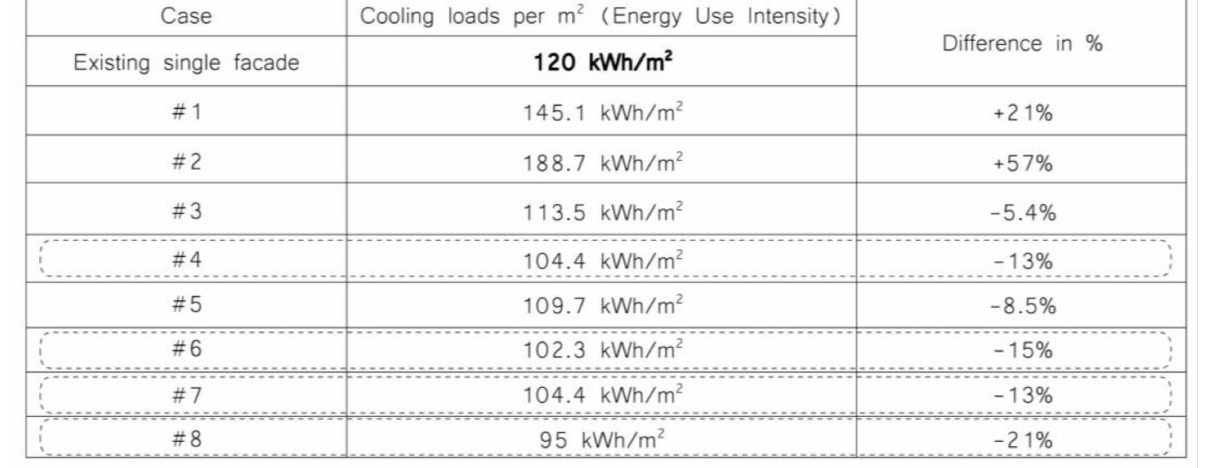
Figure 21. Results of the EUI calculations for the cooling loads of the case studies shown in Figure